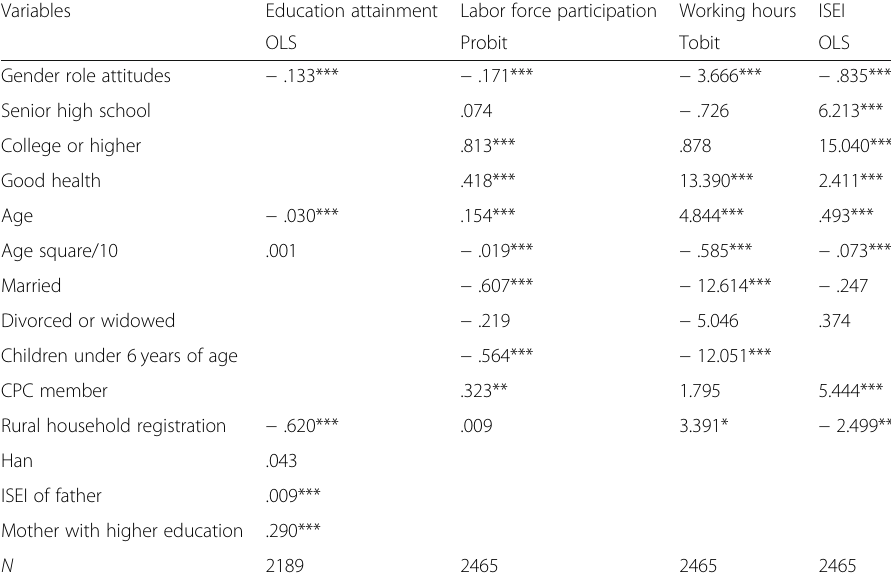
Table 5 Mechanisms of gender role attitude effects on women ’ s income